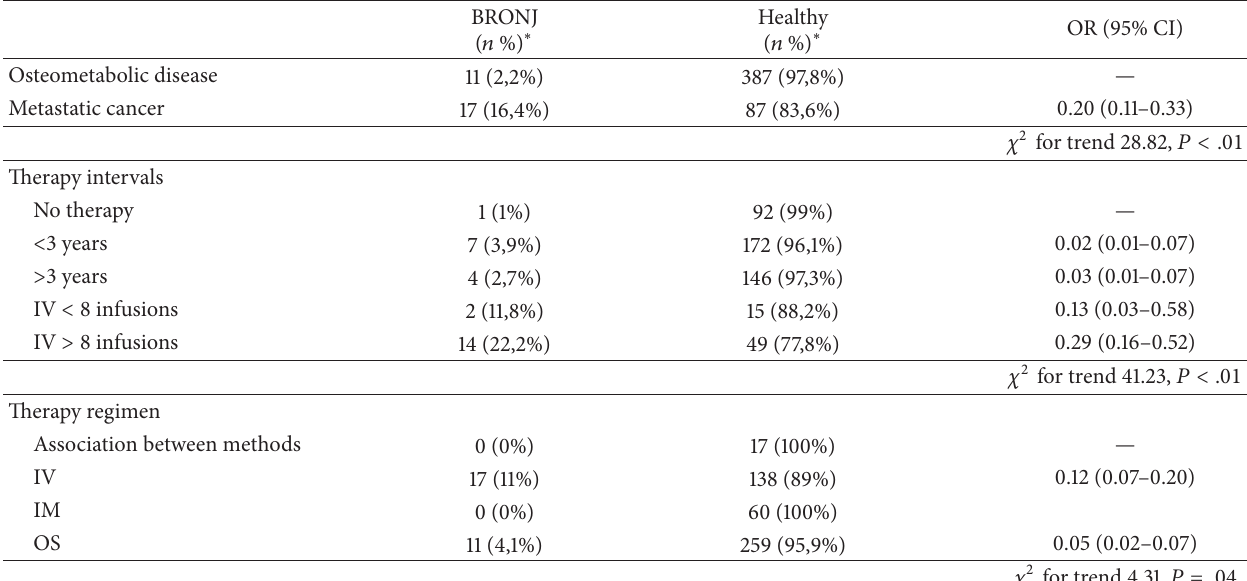
Table 4: Sample distribution of CROMa patients by BRONJ presence.